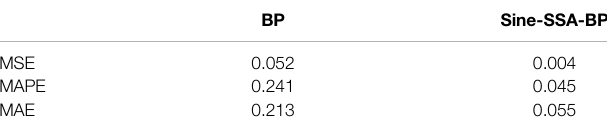
TABLE 5 | Prediction and evaluation